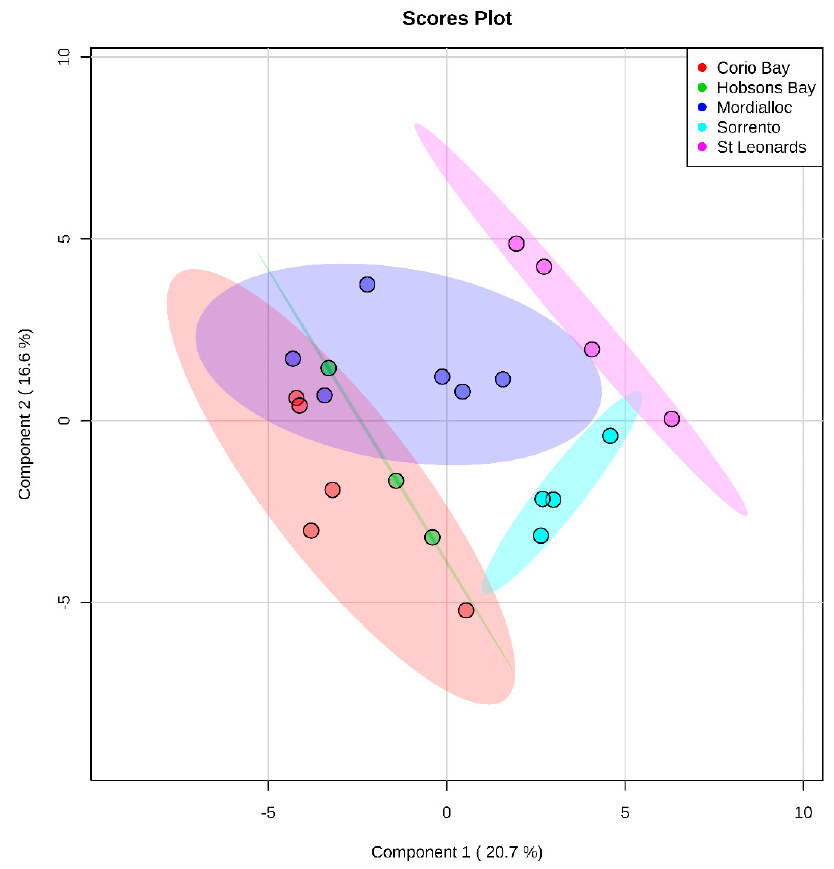
Figure 2. Partial least squares discriminant analysis (PLS-DA) showing the separation of polar metabolites in the livers of female sand flathead ( Platycephalus bassensis ) collected at five sites in Port Phillip Bay, Victoria, Australia in March 2015. Cross validation results are in the Supplementary Materials as Figure S1 and Table S1.